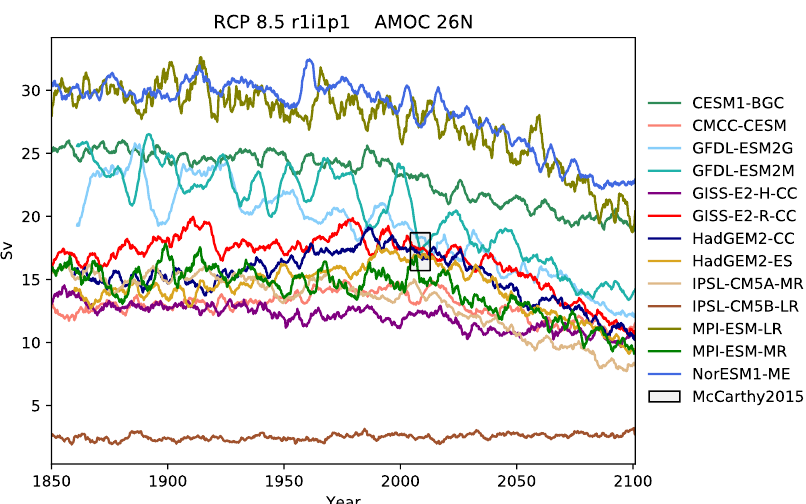
Figure 12. The Atlantic meridional overturning circulation at 26 ◦ N in a subset of CMIP5 models. Each model is shown as a full line, and the historical measurement is shown as a grey area. The model data are a 5-year moving average.